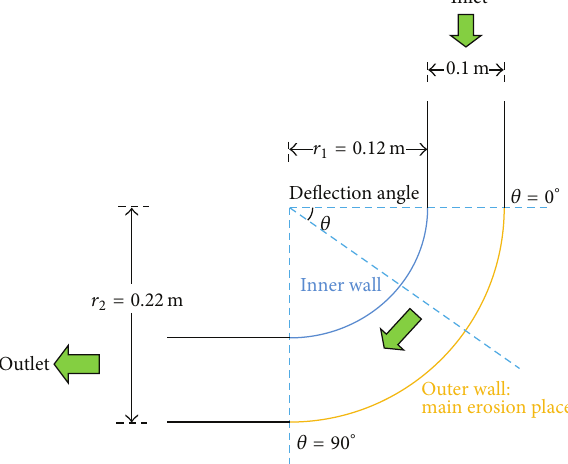
Figure 1: Schematic chart of the model